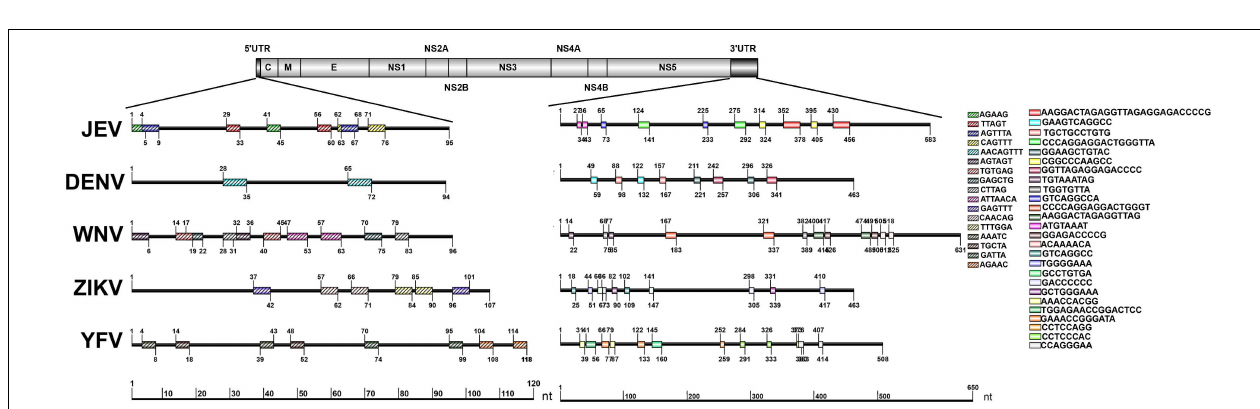
FIGURE 4 | Schematic localization of the repeat sequences in UTRs of medically important Flaviviruses . Different color boxes indicate different repeat sequence units. The start and end positions of the repeat sequence unit is labeled upward and downward lines,